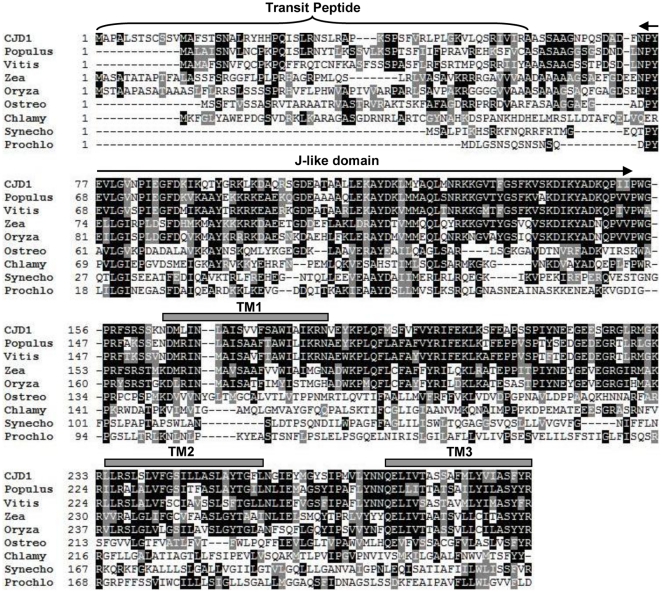
Analysis of Arabidopsis CJD1 inferred amino acid sequence.Clustal W (1.83) alignment of CJD1 with selected homologues. Identical residues are depicted by black boxes while similar residues are shaded with grey boxes. The bracket delineates the predicted transit peptide, grey bars indicate predicted transmembrane domains (TM1, 2 and 3) and the double arrow defines the J-like domain. Abbreviations and GenBank Protein ID: CJD1, 18390922, Populus, Populus trichocarpa, 222862208; Vitis, Vitis vinifera, 225453038; Zea, Zea mays, 194705880; Oryza, Oryza sativa (japonica cultivar), 78708817, Ostreo, Ostreococcus lucimarinus, 145347386; Chlamy, Chlamydomonas reinhardtii, 159491044; Synecho, Synechocystis sp. (PCC6803), 16329734; Prochlo, Prochlorococcus marinus (NATL2A), 72001786.